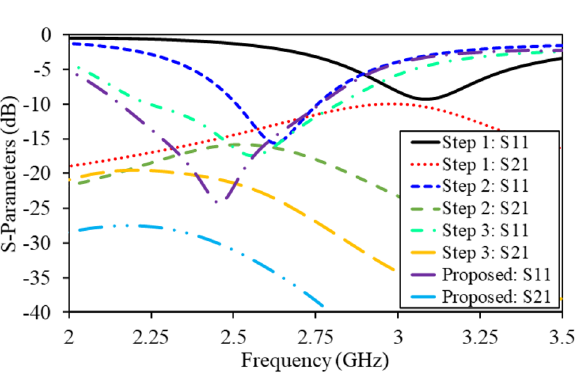
Figure 5. S 11 and S 21 of the antenna in optimization stages (optimization goals: compactness, large bandwidth and high